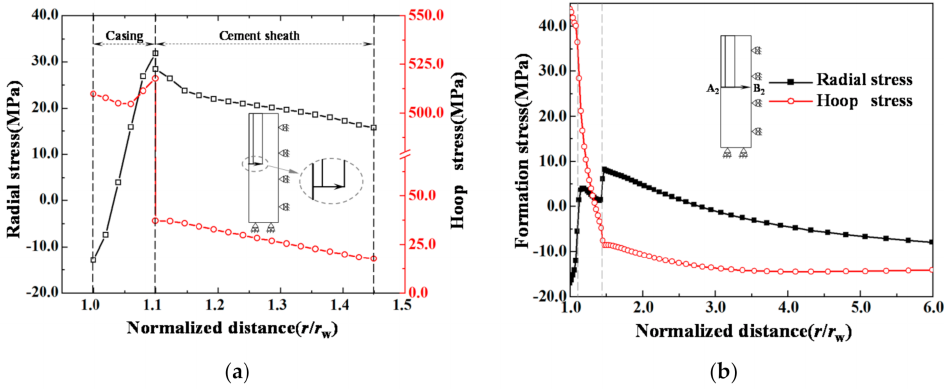
Figure 8. Stress changes: ( a ) local stress change of the casing-cement sheath; ( b ) stress change of the A 2 B 2